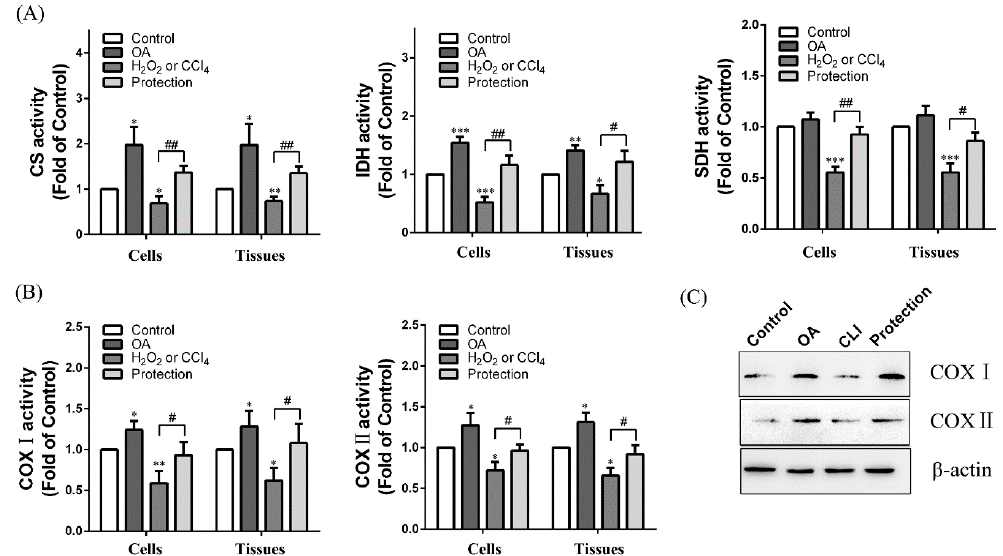
Figure 5. Effects of OA on TCA cycle and electron transport chain. ( A ) The enzymatic activity of citrate synthase (CS), isocitrate dehydrogenase (IDH), and succinate dehydrogenase (SDH) in the cells and tissues. Groups were as described in “Methods: Cell line and Reagents, animals”; ( B ) The activity of complex (COX) I and II in the cells and tissues. Groups were as described in “Methods: Cell line and Reagents, animals”; ( C ) Western blot assay. Groups were as described in “Methods: animals”. The experiments were repeated at least three times. The results are presented as the mean ± SD. * p < 0.05, ** p < 0.01 and *** p < 0.001 compared with the control. # p < 0.05, ## p < 0.01 compared with the H 2 O 2 or CCl 4 group.